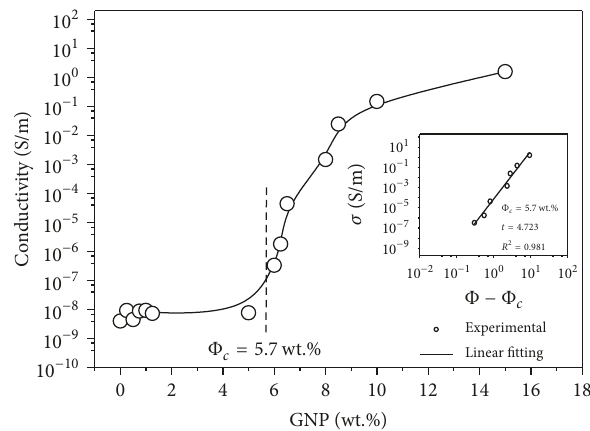
Figure 1: Electrical conductivity of PET-GNP nanocomposites. The insetplotislog 𝜎 versuslog( Φ−Φ 𝑐 )fordeterminationofpercolation threshold